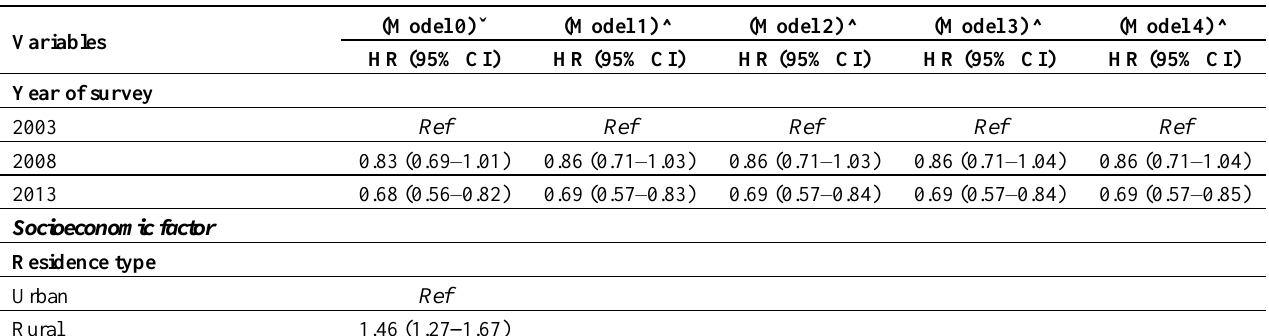
Table 3. Model for neonatal